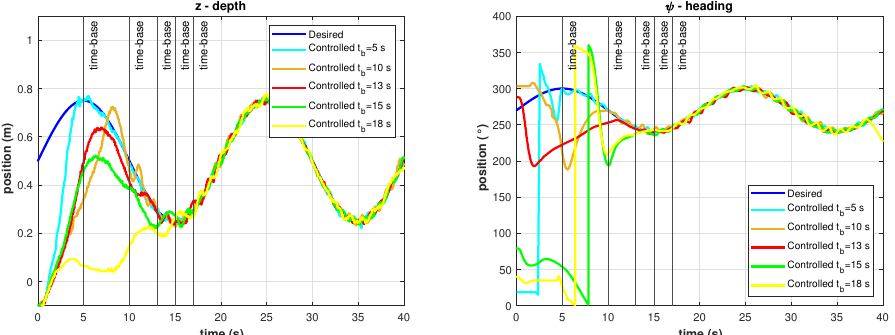
Figure 15. Controlled trajectories with the model-free high-order SMC with finite-time convergence in predefined-time. ( Left ) Depth. ( Right )